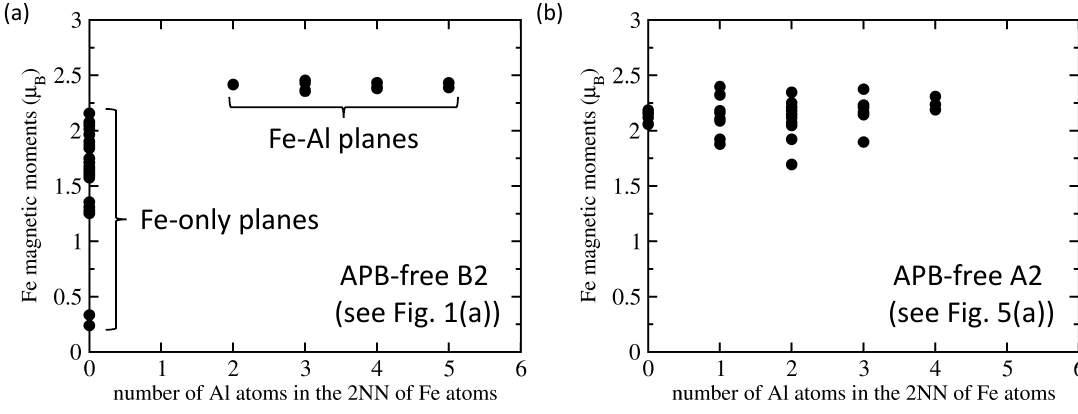
Figure A1. Calculated local magnetic moments of Fe atoms as a function of the number of Al atoms in their second nearest neighbor (2NN) shell of the Fe atoms. Part ( a ) summarizes them in the APB-free bulk B2 phase (visualized in Figure 1a) and part ( b ) for the APB-free bulk A2 phase shown in Figure